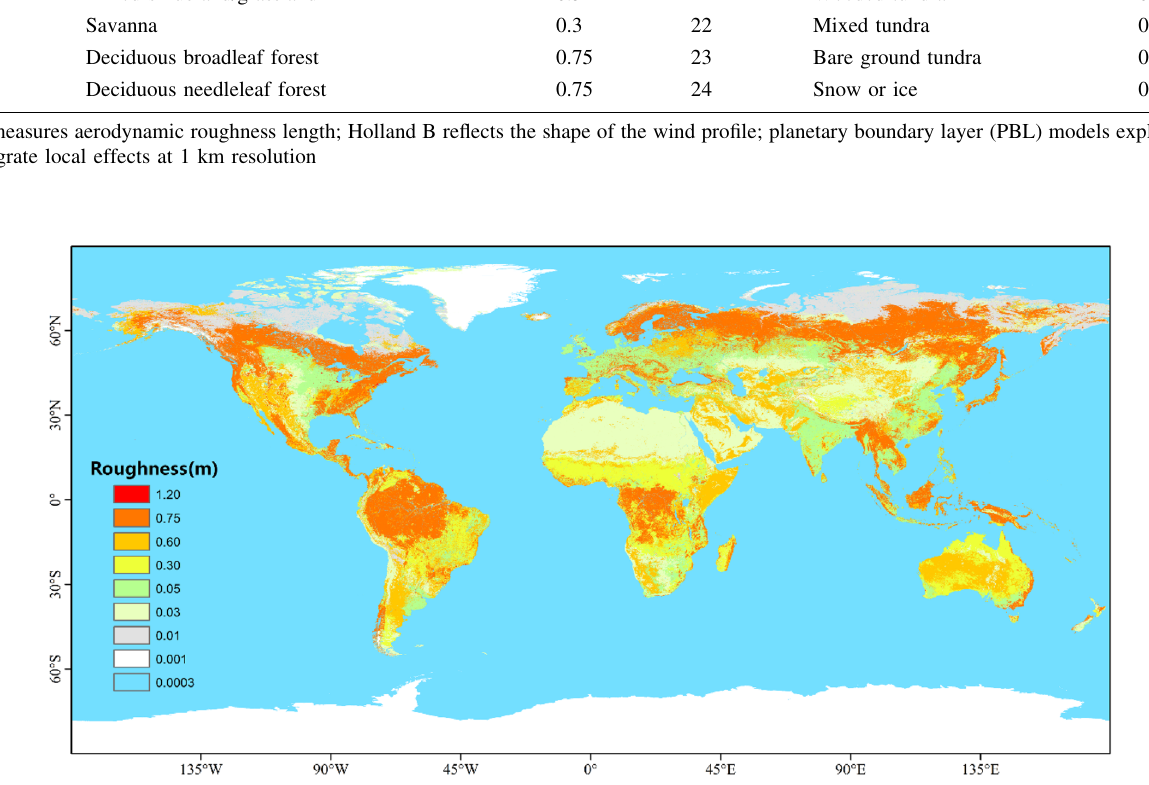
Fig. 2 Global roughness length estimated from GLCC data based on the USGS Land Use / Land Cover System